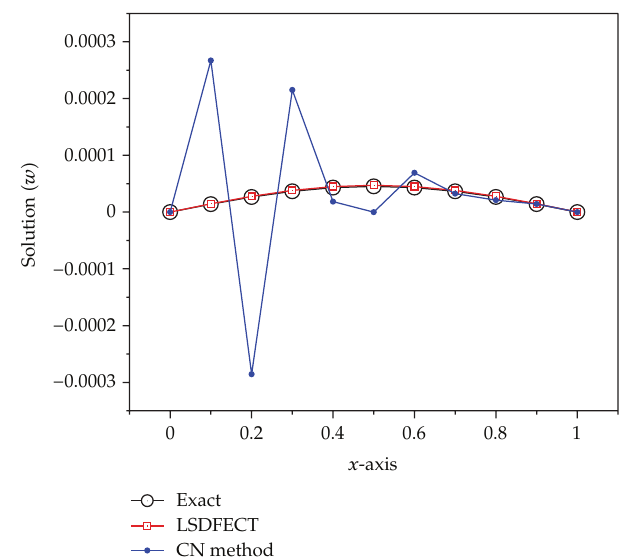
Figure 5: Comparison of the numerical solution by our method (cid:2) LSDFECT (cid:3) , CN method, and exact solution of Problem 5 at di ff erent space points for h (cid:8) 0 . 1, ν d (cid:8) 0 . 02, and k (cid:8) 4 at T (cid:8)